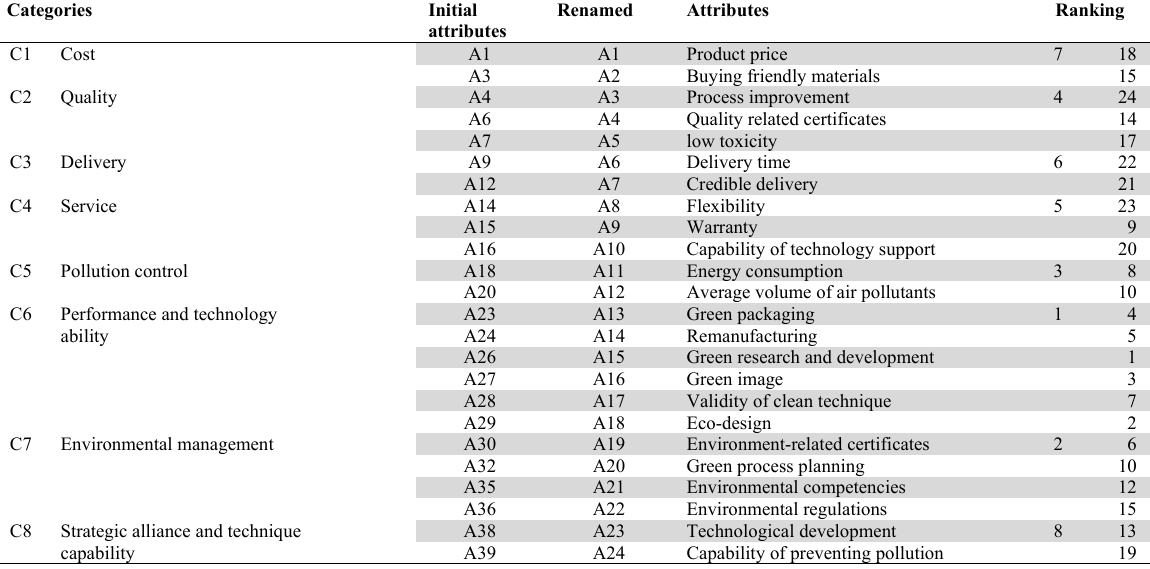
Categories and factors screening out after FDM round